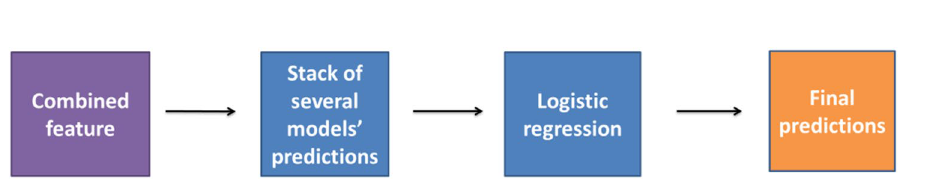
Figure 7. Ensemble stacking technique. It was used to combine two different information from separate feature engineering, CFPs and OCT biomarkers, and then to choose differernt learning models (including XGBoost, LightGBM, and CatBoost) to create new features by stacking technique for final